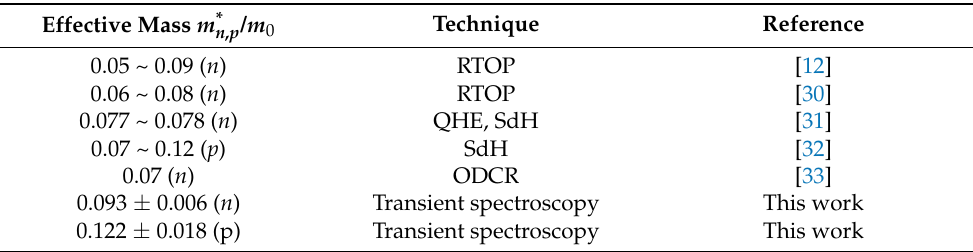
Table 1. Electron effective masses of InGaAsN/GaAs quantum well heterostructures estimated by various